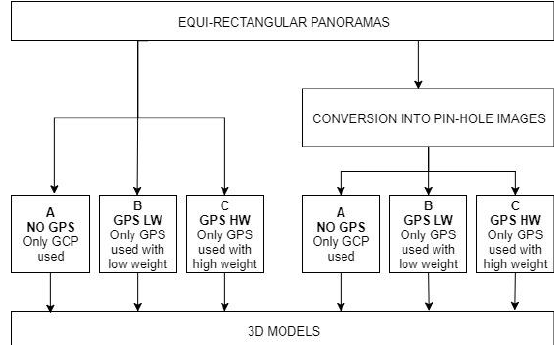
Figure 3. The different options for images